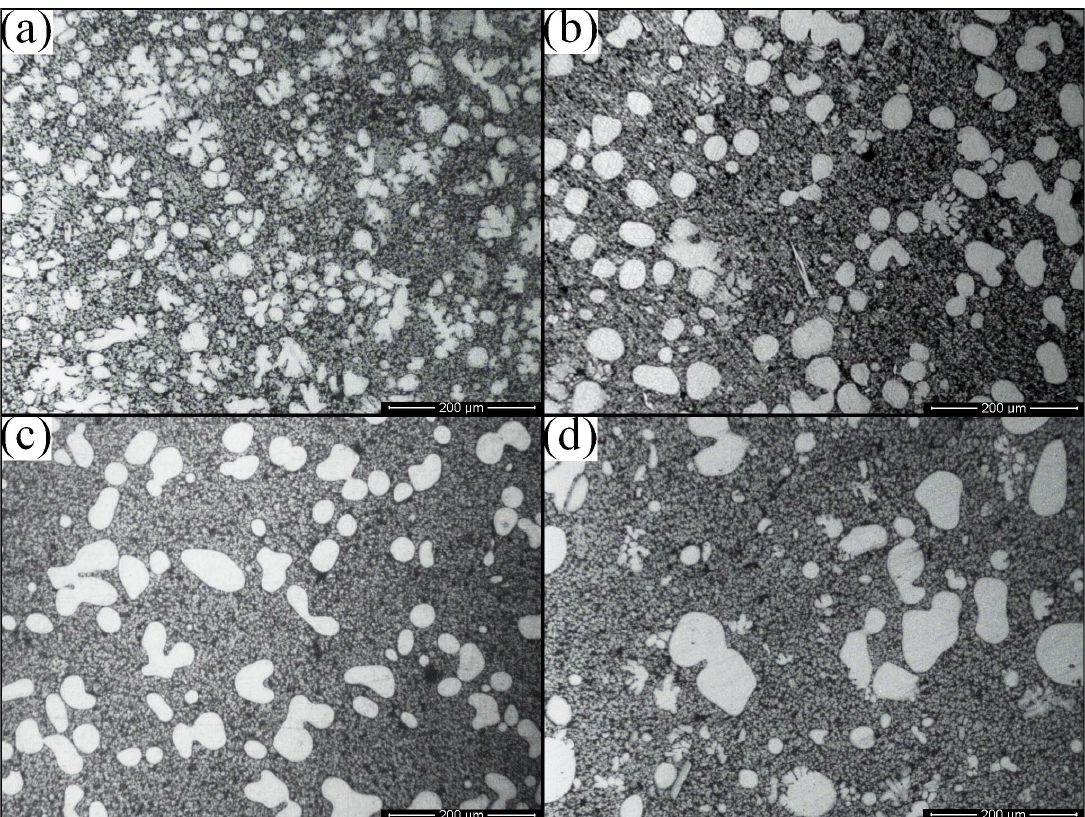
Figure 6. Microstructures of ZA27 alloy rheo-diecasting by SIM under different holding time (a) 0min; (b) 3min; (c) 5min and (d)